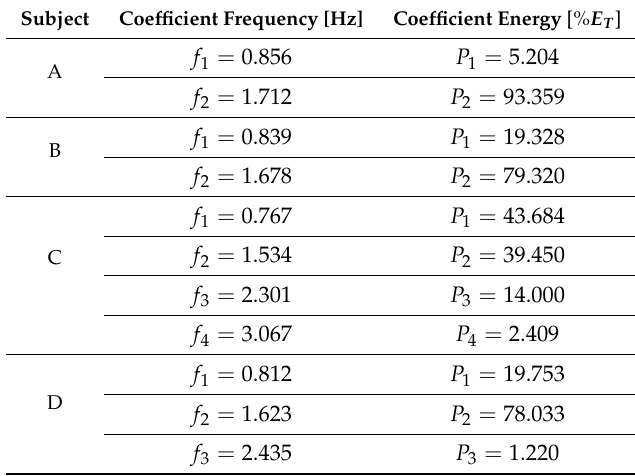
Table 1. Coefficient frequencies and its energy contribution to the DFS of the vertical